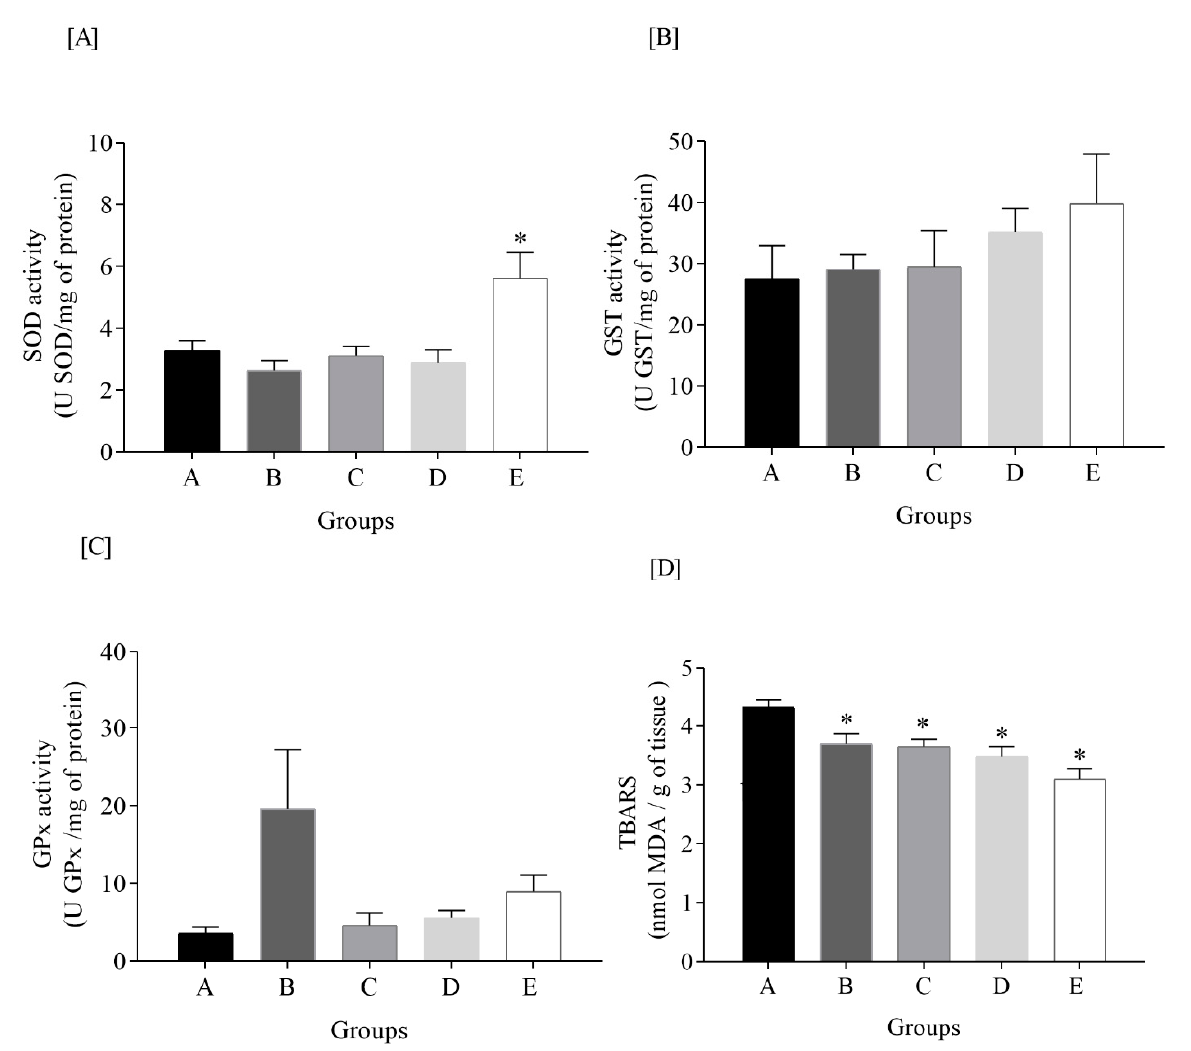
Figure 5. Oxidative status markers in the liver of silver catfish ( Rhamdia quelen ) fed with diets containing different concentrations of Cinnamomum cassia essential oil (CCEO) for 60 days ( A – D ). Letters of the bars: (A) Control diet; (B) supplementation of 0.25 mL of CCEO per kg of diet; (C) supplementation of 0.5 mL of CCEO per kg of diet; (D) supplementation of 1 mL of CCEO per kg of diet; (E) supplementation of 2 mL of CCEO per kg of diet. SOD: superoxide dismutase; GST: glutathione S-transferase; GPx: glutathione peroxidase; TBARS: thiobarbituric acid reactive species. Values are expressed as the mean ± SEM ( n = 8). * Asterisk indicates significant difference from all other groups (one-way ANOVA and Tukey’s test, p < 0.05).